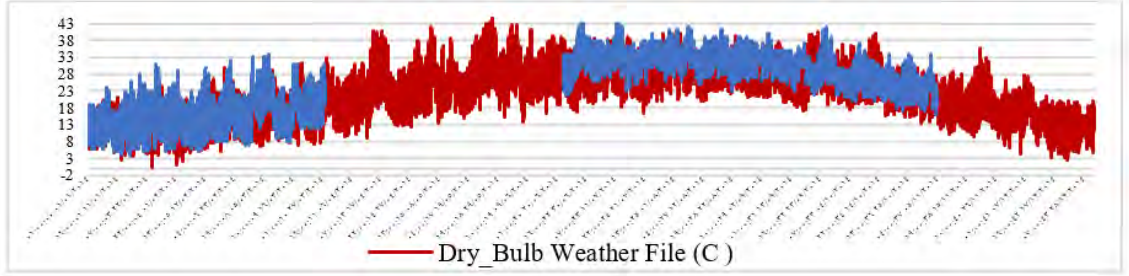
Figure 5. A comparison between the typical year weather file, and the actual measurements’ temperatures for the year of